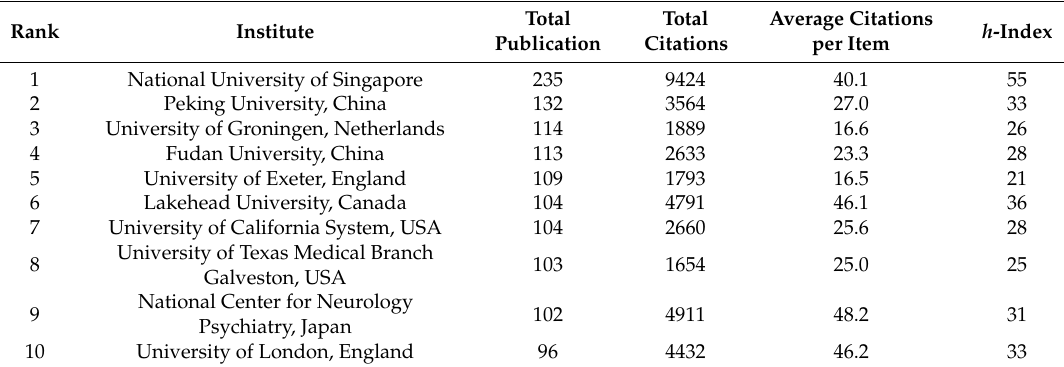
Note: The rank of this table was based on the number of total publications.